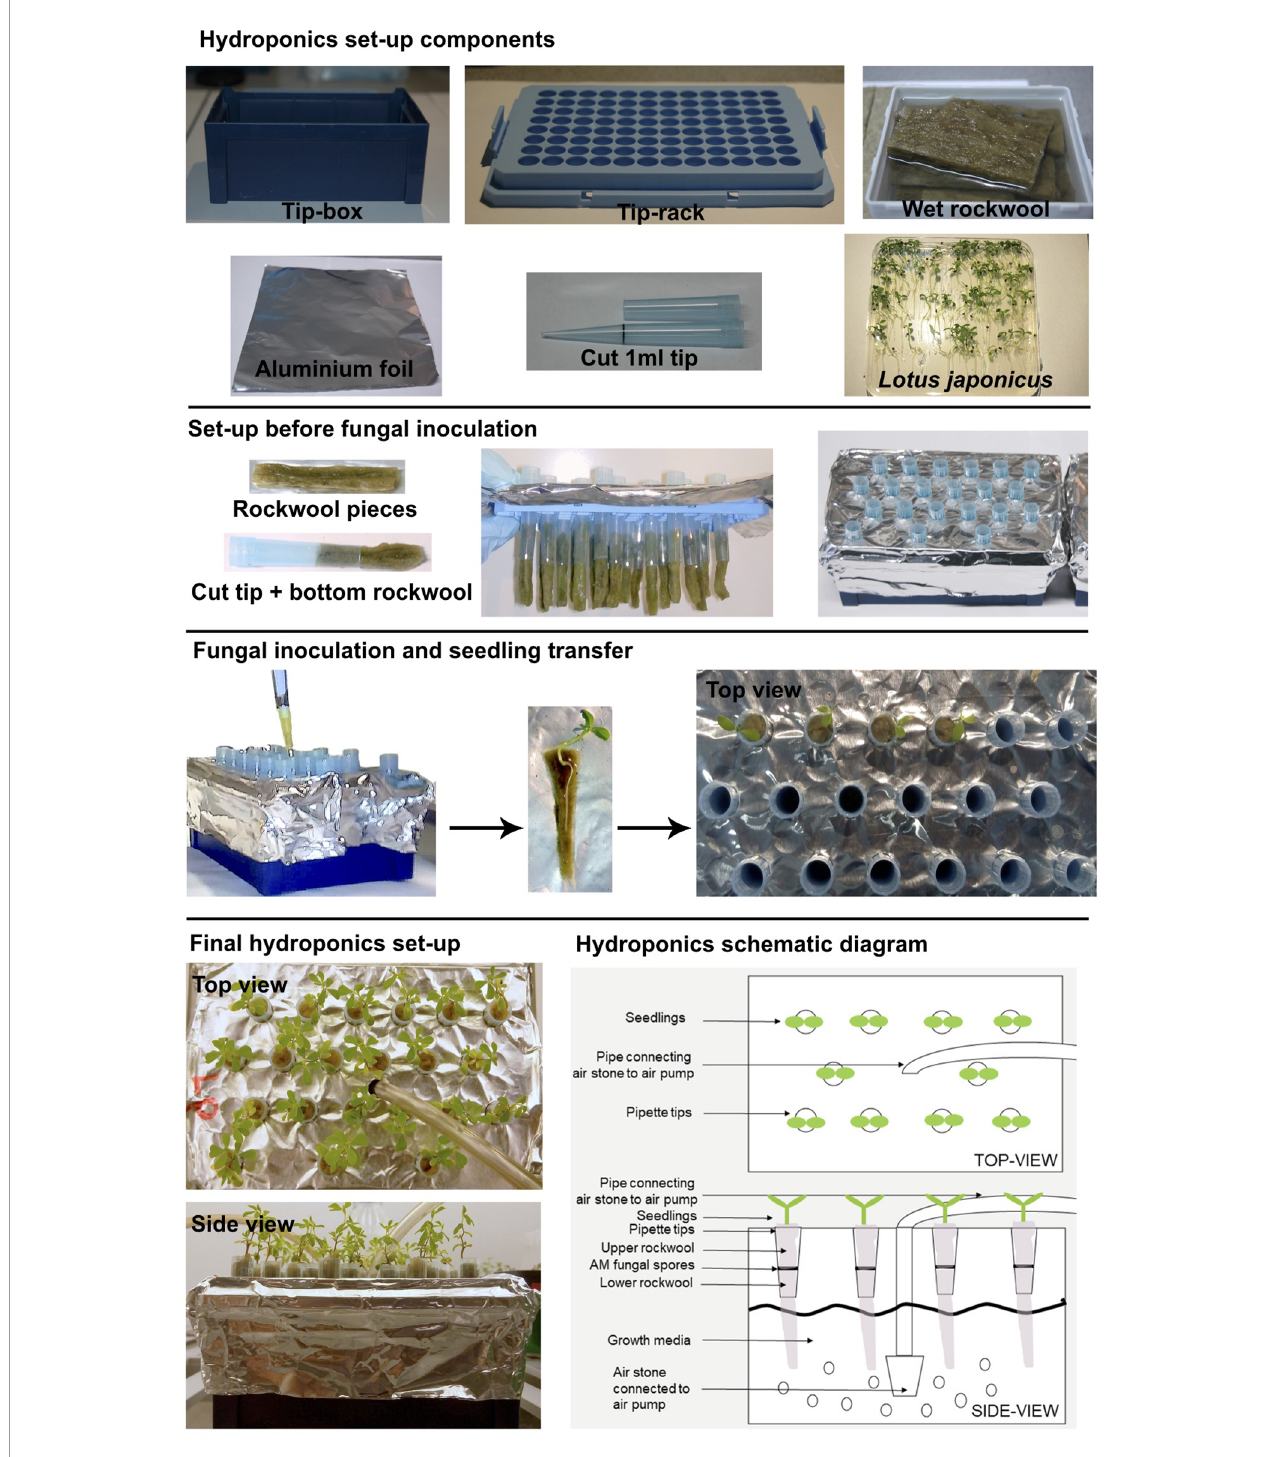
FIGURE 1 | Tip-wick hydroponics. Basic set-up for Lotus japonicus